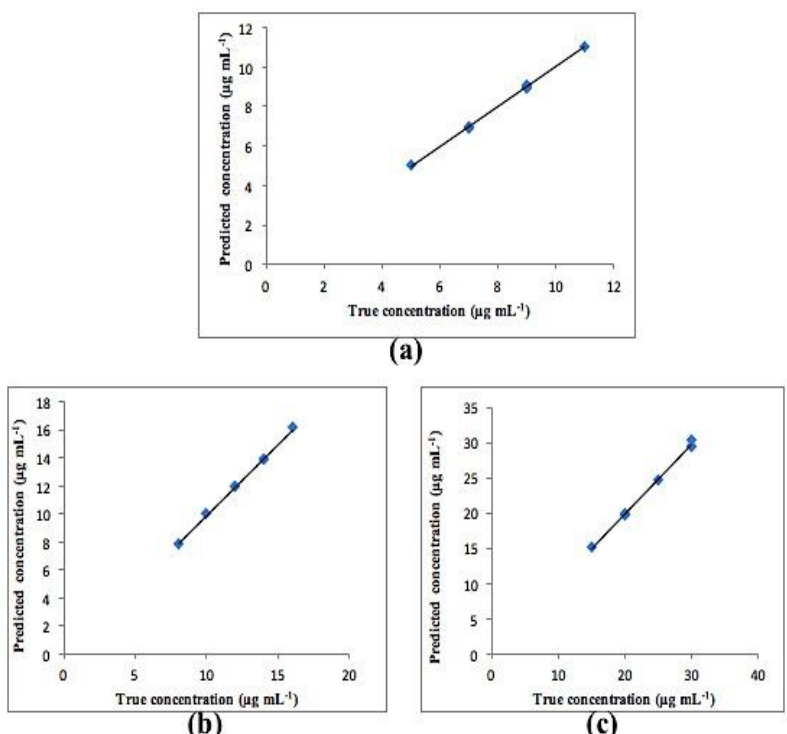
Figure 6. Calibration curve between true and found concentrations for ( a ) CS, ( b ) Deg1 and ( c ) Deg2 for PLS-2 model.